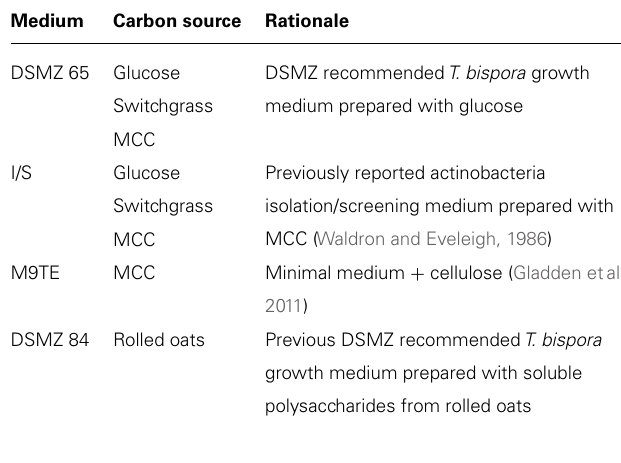
Table 1 | Thermobispora bispora growth conditions tested in this